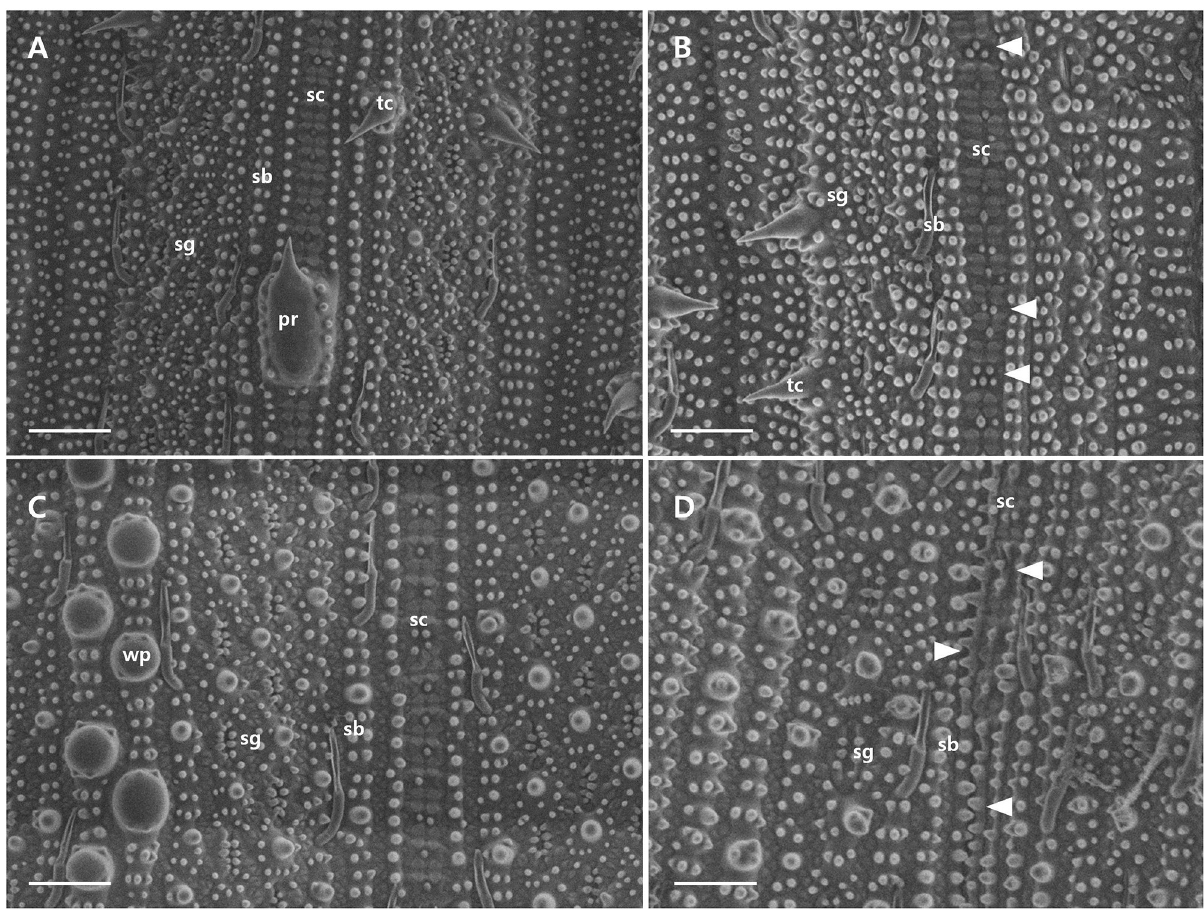
Fig 3. Scanning Electron Micrograph (SEM) of leaf epidermis (1000 × magnification). (A, B) The adaxial surface in the wild-type and the dr mutant (C, D). The adaxial surface in the wild-type and the dr mutant. sb; silica body, sc; silicified dumbbell-shaped cells, sg; stomatal guard, pr; protuberances, tc; trichome, wp; wart-like protuberance. Arrow heads indicate undeveloped or degraded silica cells. Bars = 50 μ m.